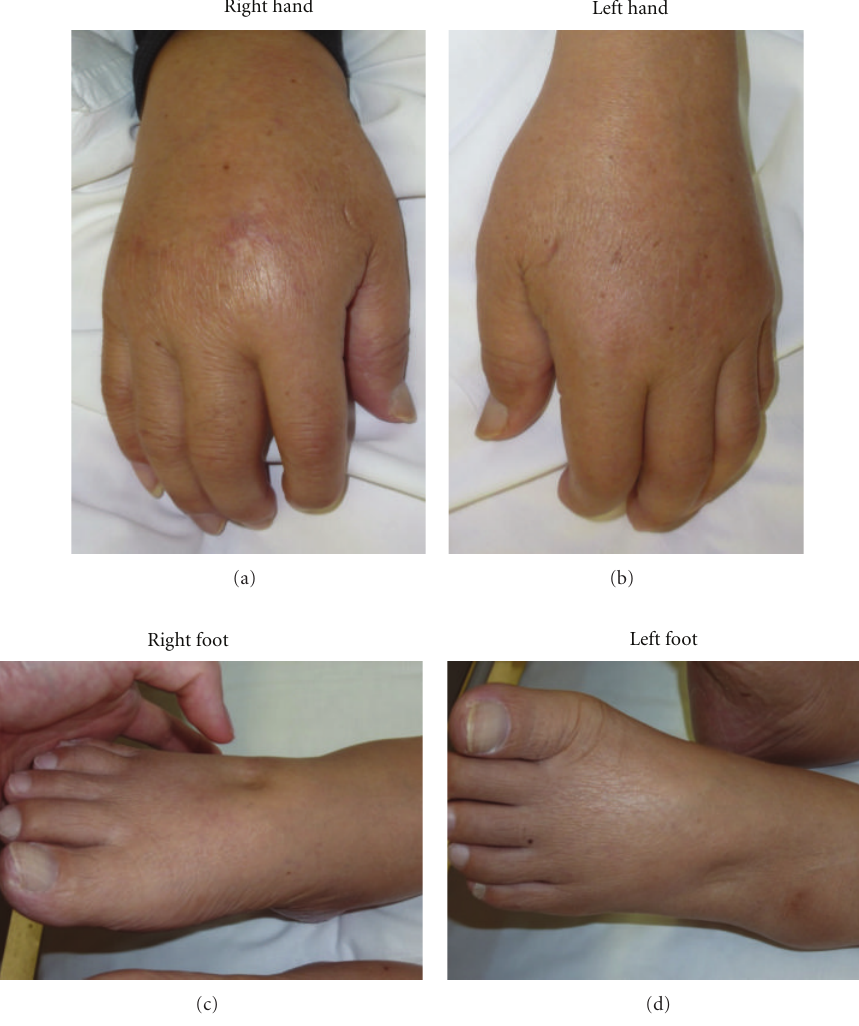
Figure 1: Photographs of the bilateral hands and feet. Edematous hands and feet with pitting edema were observed.